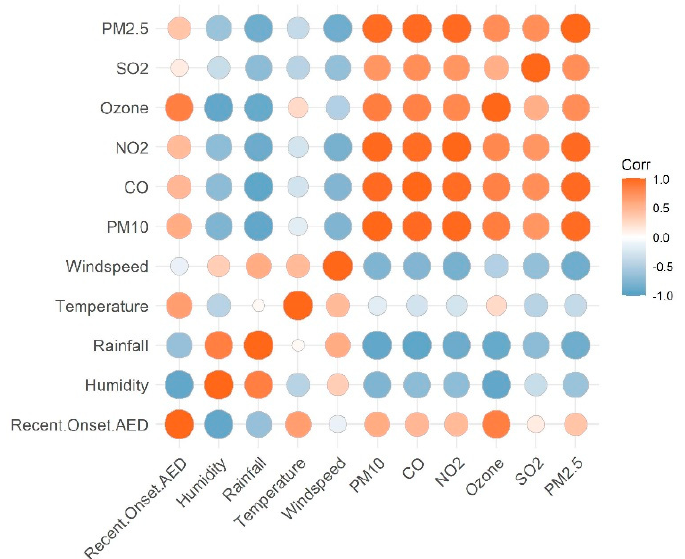
Figure 5. Correlation matrix of environmental factors and air pollution indicators on the prevalence of recent onset allergic eye disease (AED) in the district of